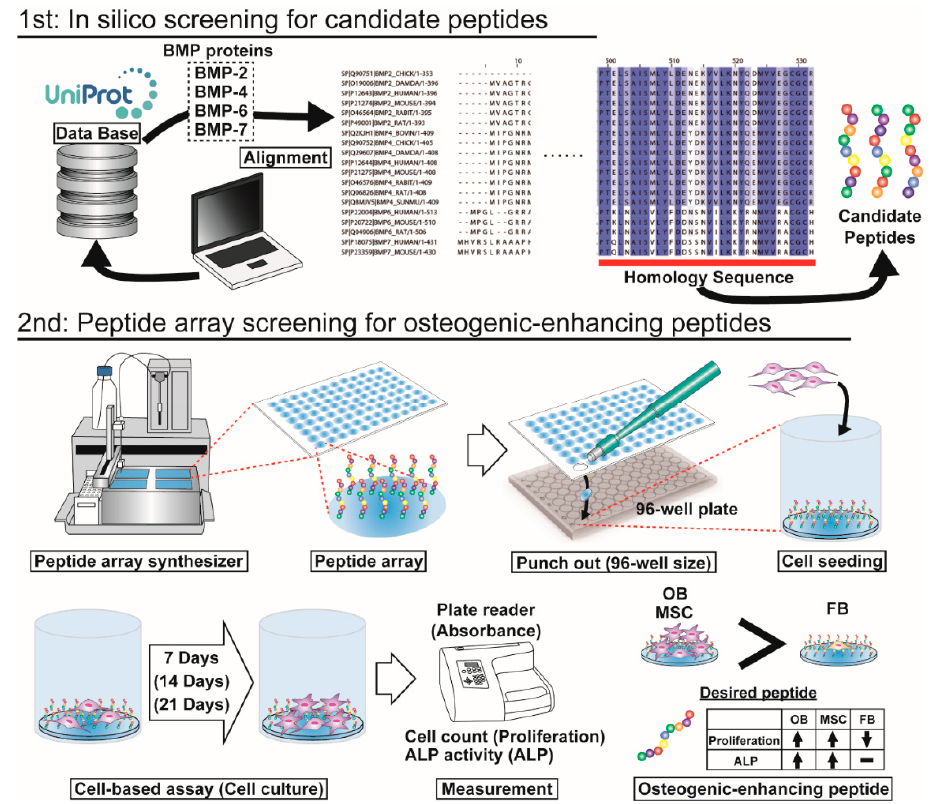
Figure 1. Schematic of this study. First, in silico screening of candidate peptides was performed. From the protein database UniProt, the sequences of several BMPs, such as BMP-2, BMP-4, BMP-6 and BMP-7, from several species were obtained. The protein sequences were aligned in the UniProt database, and homologous sequences were defined. From the homologous sequences, candidate 9-mer peptides were selected for the next peptide array screening. Second step, peptide array screening of osteogenic-enhancing peptides was conducted. A peptide array was fabricated using a peptide array synthesizer and was punched out in the 96-well plate size in a 96-well plate. Cells were seeded and cultured for several days. Cell proliferation and osteogenic differentiation were detected by cell counting and ALP activity, respectively. The desired peptides exhibit higher proliferation of osteoblasts (OBs) and MSCs than of fibroblasts (FBs) and high ALP activity in OBs and MSCs.